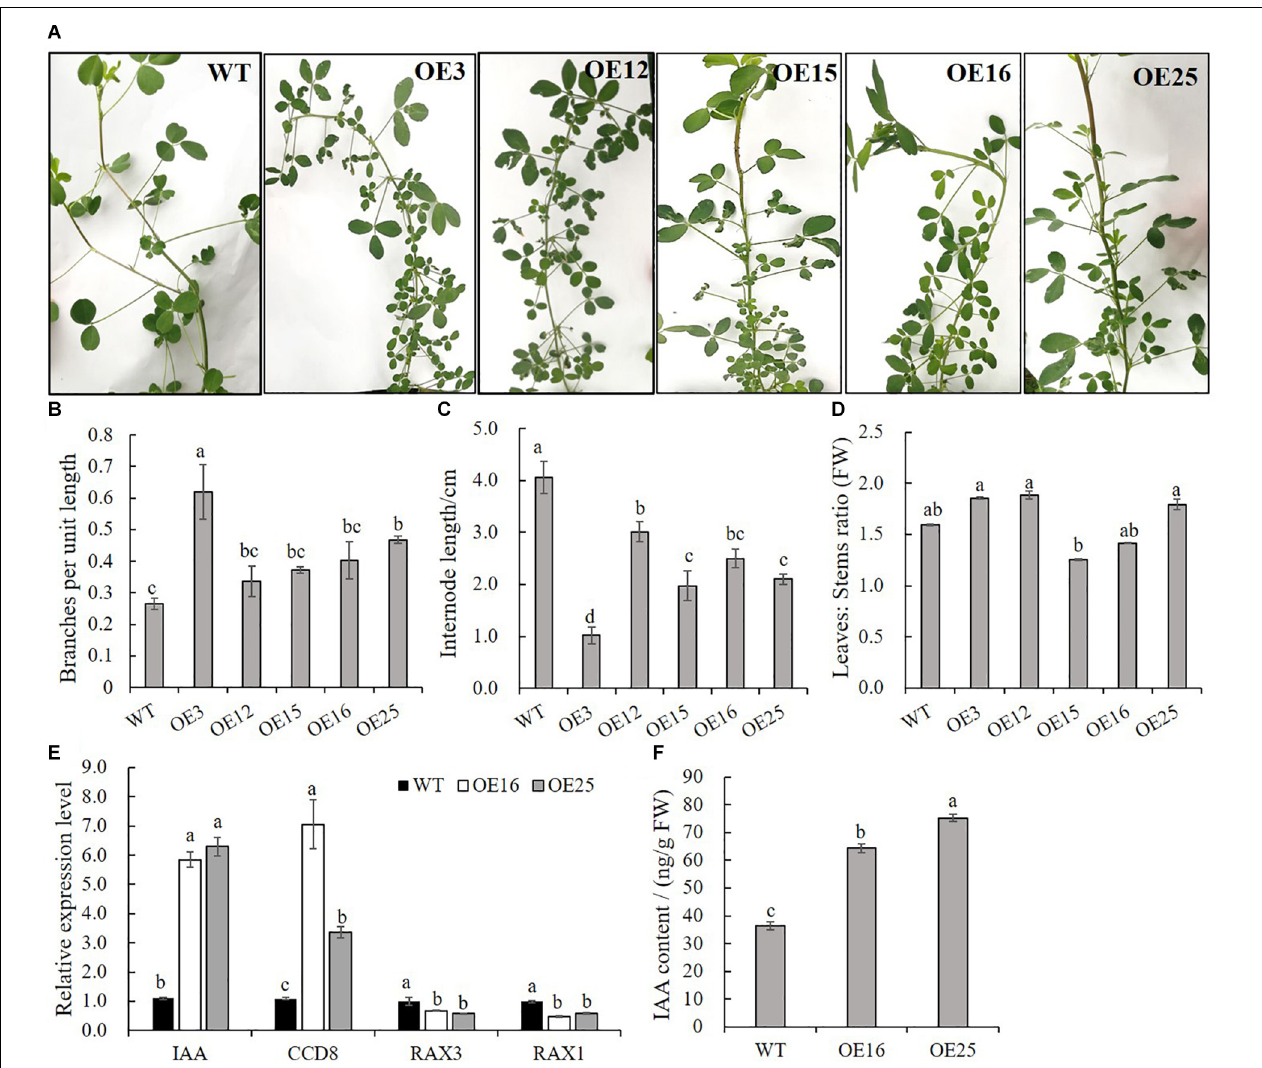
FIGURE 4 | Branching characteristics of WT plants and OE-MsASMT1 transgenic plants. (A) Branching phenotype of three-month-old WT plants and several OE-MsASMT1 transgenic plants; (B–D) The number of lateral branches per unit length on the main branch (B) , the internode length between two lateral branches (C) and the ratio of fresh leaves to fresh stems (D) of WT plants and OE-MsASMT1 transgenic plants after grown in greenhouse for three months; (E) Relative expression level of genes related to plant branching in WT plants and OE-MsASMT1 transgenic plants; (F) IAA content of WT plants and OE-MsASMT1 transgenic plants. Data are presented as mean ± SE ( n = 3). The letters indicate the differences between WT and OE-MsASMT1 transgenic plants according to ANOVA analysis ( p < 0.05).